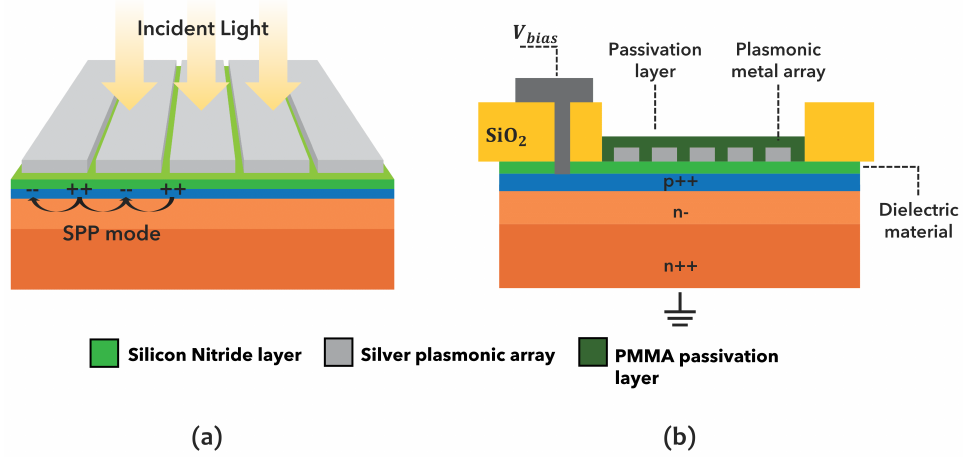
Figure 1. ( a ) Three-dimensional sketch of the proposed structure of plasmonic metal array fabricated on the top of a silicon photodiode passivated with a thin dielectric film and supporting surface plasmon polaritons (SPP) mode, and ( b ) cross-section of the plasmonic metal array over the active area of the Si-PD (p++/n-/n++), with the Si-PD passivated by a thick SiO 2 layer. The bias voltage ( V bias ) is applied from the metal top contact, while the Si-PD is grounded from the bottom.